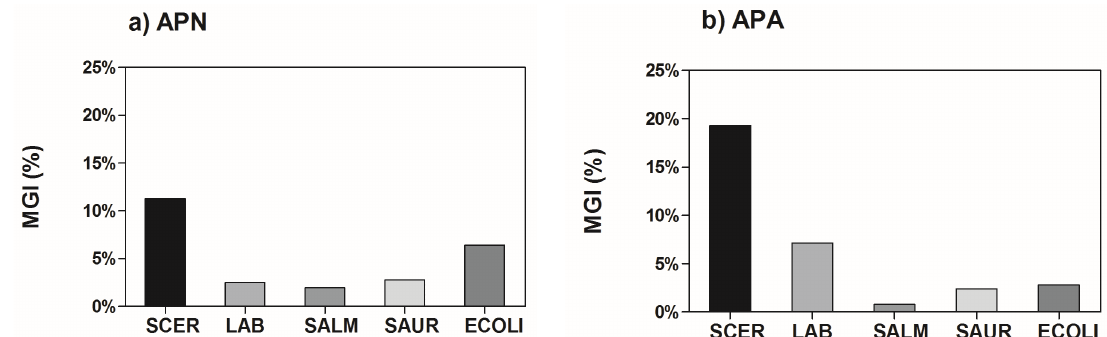
Figure 4. Total viable counts of tomato juices with added phenolic extracts (neutral, APN; acidic, APA) compared to control during the storage time of 10 days at 4 °C. The acceptability threshold at day 4 is indicated with a dotted line. Different letters indicate significant differences ( p < 0.05) between samples. CFU, colony forming unit.